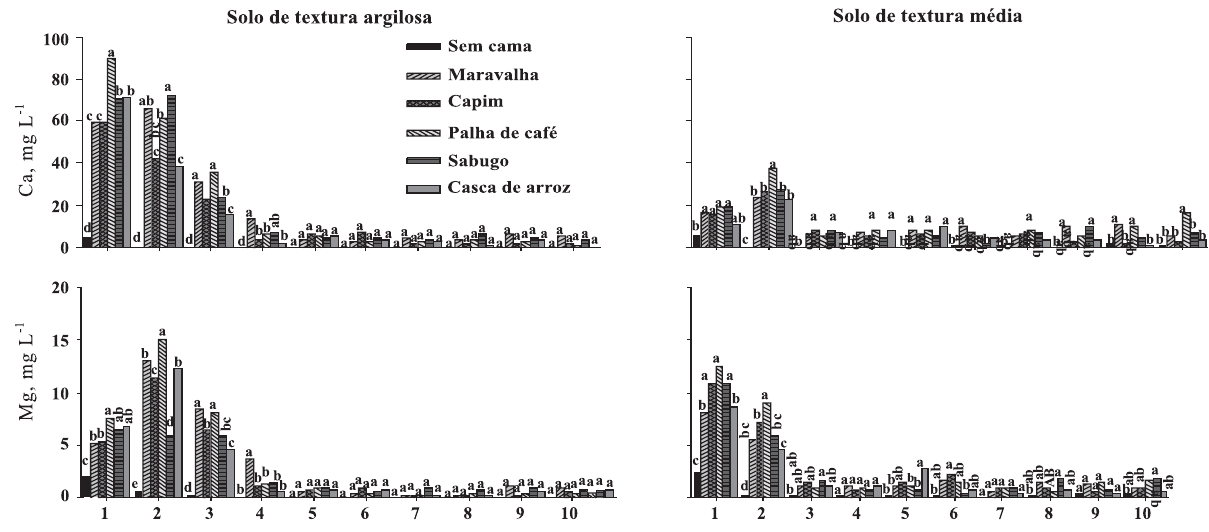
Figura 2. Concentrações de Ca e Mg em percolados coletados sucessivamente, ao longo do tempo, em dois Latossolos de texturas distintas, que receberam 160 t ha -1 , base material seco, de cinco tipos diferentes de cama de aviário, no anel superior de colunas de percolação, comparados à testemunha, sem cama de aviário. As médias das concentrações dos elementos seguidas pela mesma letra em uma mesma percolação, para as diferentes camas, não diferiram entre si pelo teste de Tukey, a 5 %.